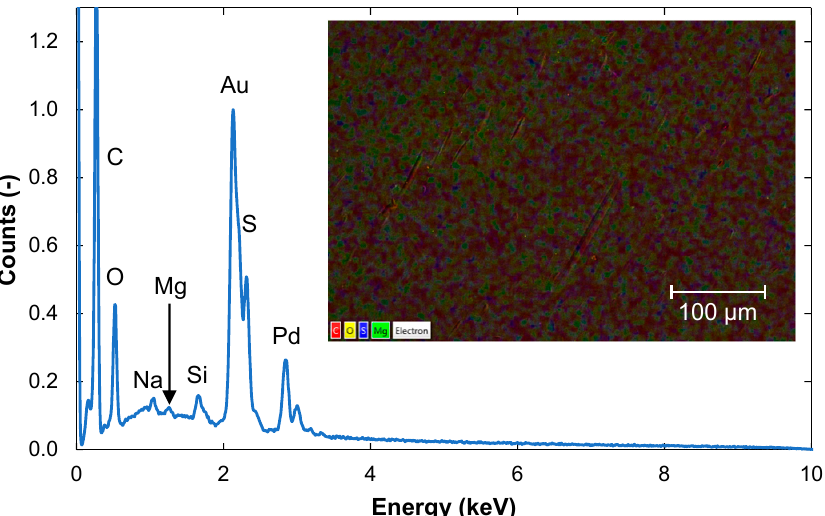
Figure 7. EDS spectrum of a membrane sample that had been cleaned for 20 h. A SEM image of the membrane surface is shown in the insert. The elements present and normalization are as described in Figure